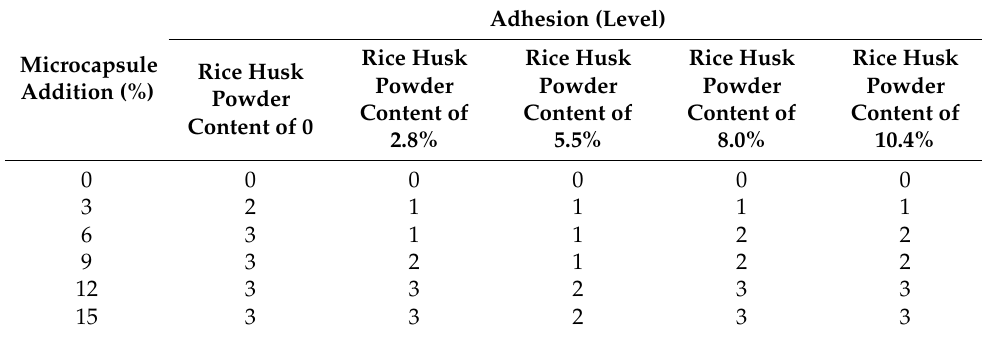
Table 10. Effect of microcapsule addition on adhesion of waterborne primer coating.